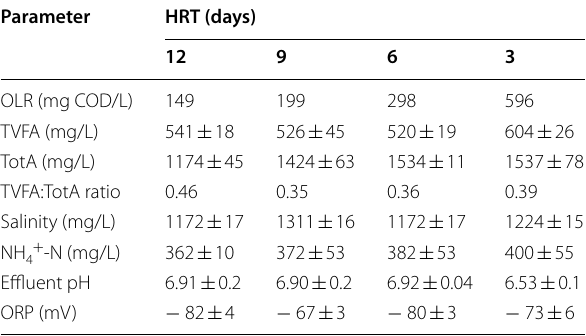
Table 3 Methanogenesis reactor effluent stability indicator parameters values at different HRT and OLR